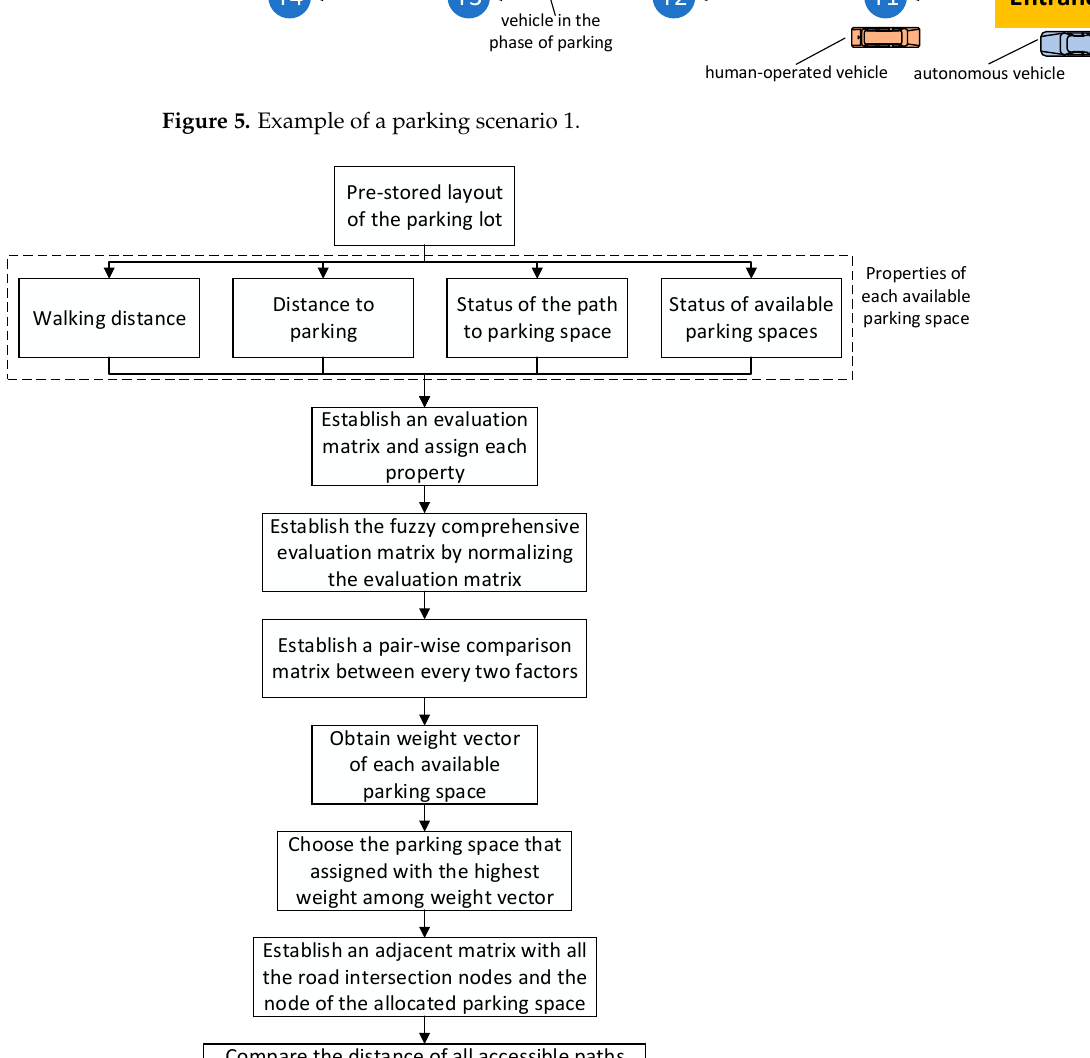
Figure 6. Flowchart for parking space selection and the shortest path planning.